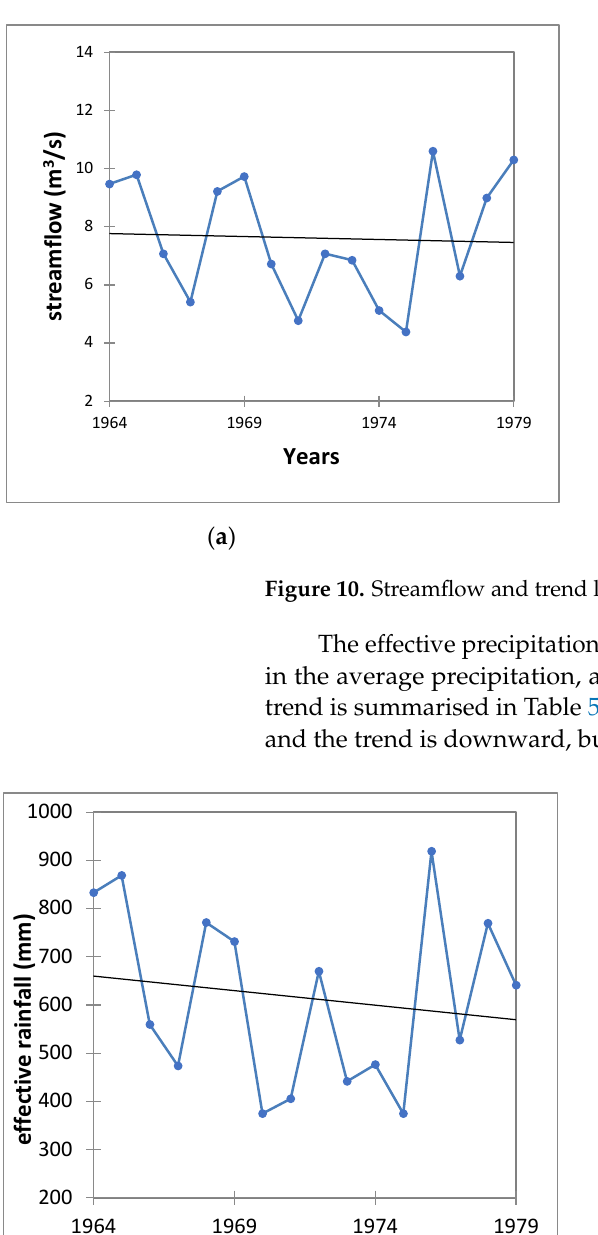
Table 4. Mann-Kendall and Sen’s slope test results for streamflow trend.